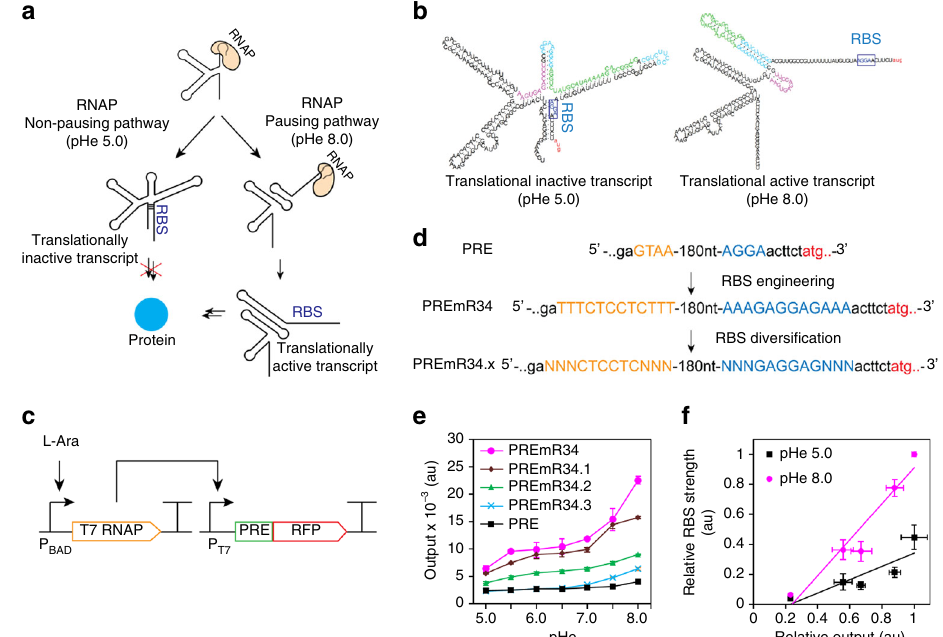
Fig. 1 Engineering the dynamic range of a wild-type pH-riboswitch. a Mechanism of action of the wild-type pH-riboswitch. During transcription, the wild- type pH-riboswitch adopts distinct folding conformations to affect the RNAP-dependent mRNA synthesis process. At low pH (pHe 5.0), mature mRNA is produced via the RNAP non-pausing pathway to yield translationally inactive transcripts with the ribosome-binding site locked by its complementary sequence. At high pH (pHe 8.0), mRNA is produced via the RNAP pausing pathway to yield translationally active transcripts with an accessible ribosome- binding site to allow translation. b Detailed folding conformations of inactive ( left ) and active ( right ) states of the wild-type pH-riboswitch. The putative wild-type ribosome-binding sequence (AGGA) is boxed . c Schematic of the genetic construct used to characterize the dynamic range of the wild-type and synthetic pH-riboswitches. d Engineering strategy to tune the dynamic range of the wild-type pH-riboswitch. The weak ribosome-binding site and its complementary sequence within the wild-type pH-riboswitch (PRE) were replaced by those of a strong ribosome-binding site RBS34 (BBa_0034) to generate the synthetic variant PREmR34. A library of PREmR34 variants (PREmR34.x) with diverse dynamic ranges was generated by varying the bases surrounding the “ core ” RBS sequence of PREmR34 (GAGGAG). e Output fl uorescence at varied extracellular pH (pHe) of the pH-sensing genetic devices ( L -ara 0.02%m/v). f Correlation between the fl uorescence output and relative strength of the RBSs embedded in the pH-riboswitch variants. The relative RBS strengths were normalized against RBS34, and the relative outputs were normalized against the output of the pH-sensing device built from RBS34. The data represent the mean of three independent experiments performed on different